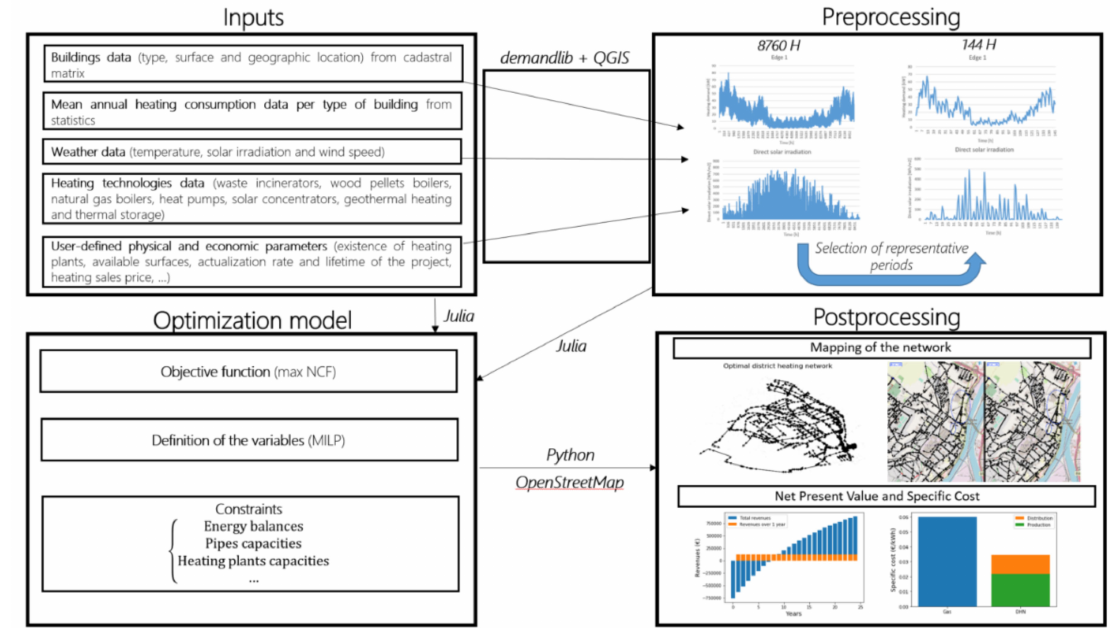
Figure 4. Architecture of the decision